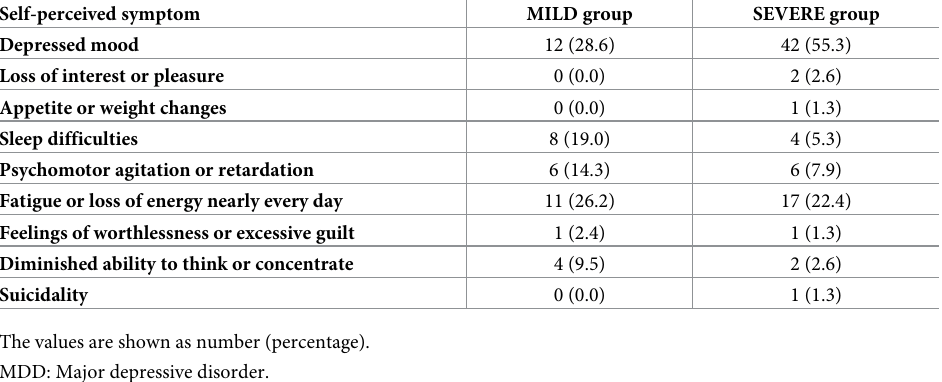
Table 2. Initial self-perceived depressive symptoms based on MDD severity (N =